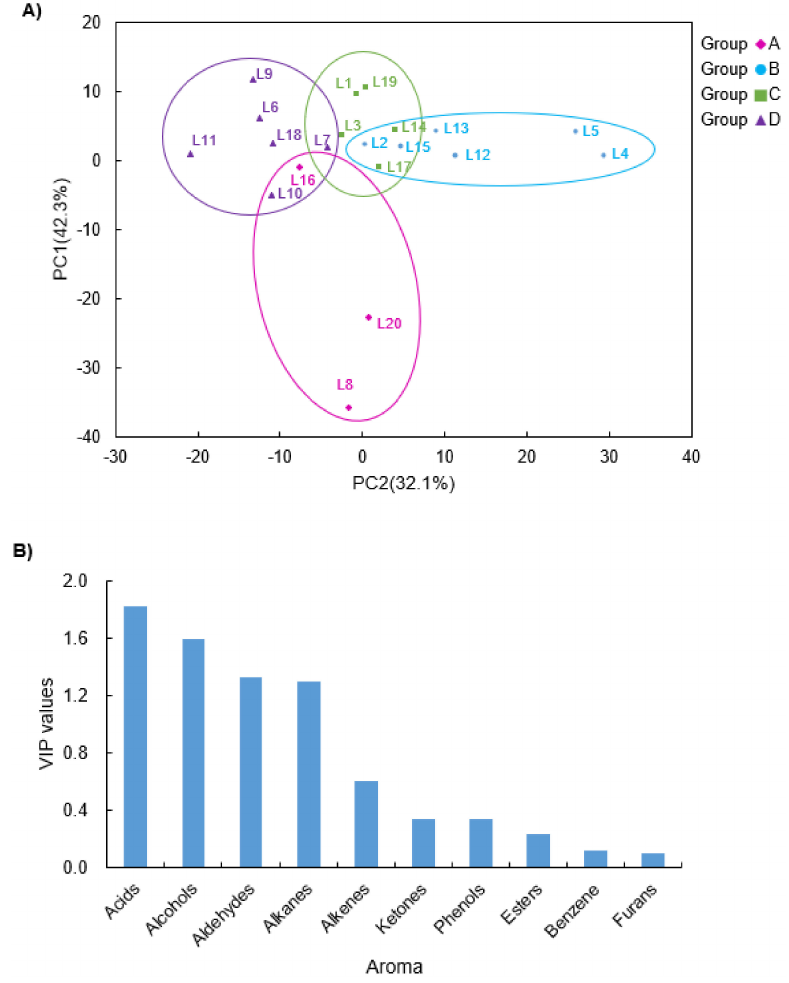
Figure 4. Partial least squares-discrimination analysis of volatile compounds of VCO from 20 geo- graphic regions. ( A ) Score plot of partial least squares-discrimination analysis of all volatile com- pounds data of Camellia oleifera seed oil. ( B ) The variables important in the projection scores of 10 chemical categories of volatile